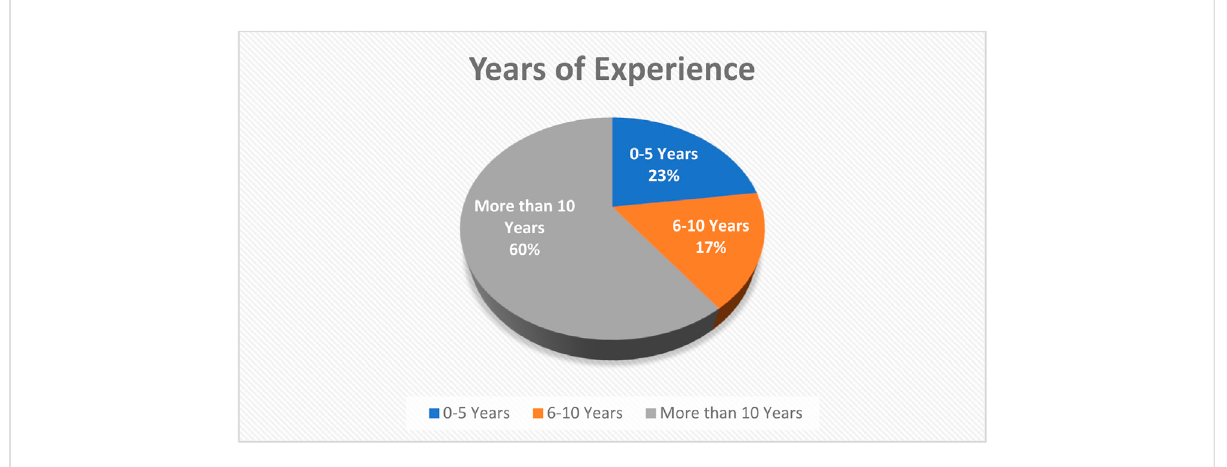
FIGURE 12 Years of experience.